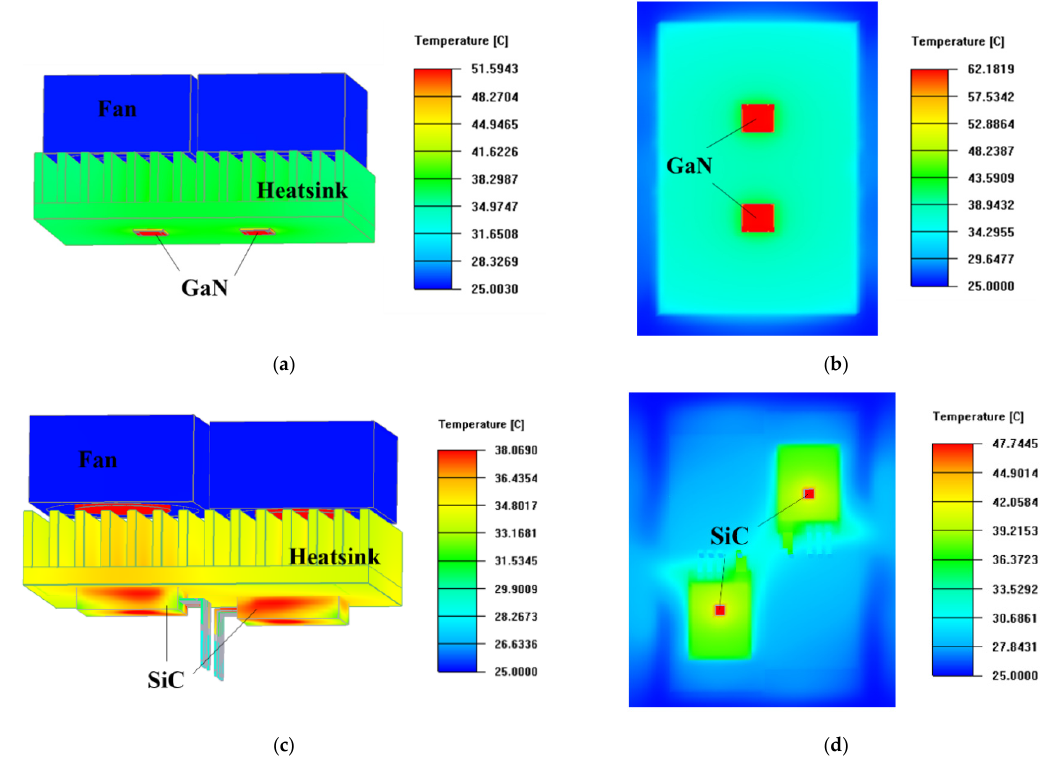
Figure 13. FEM analysis result with experimental loss: ( a ) GaN HEMT package temperature; ( b ) GaN HEMT junction temperature; ( c ) SiC MOSFET package temperature; ( d ) SiC MOSFET junction temperature.